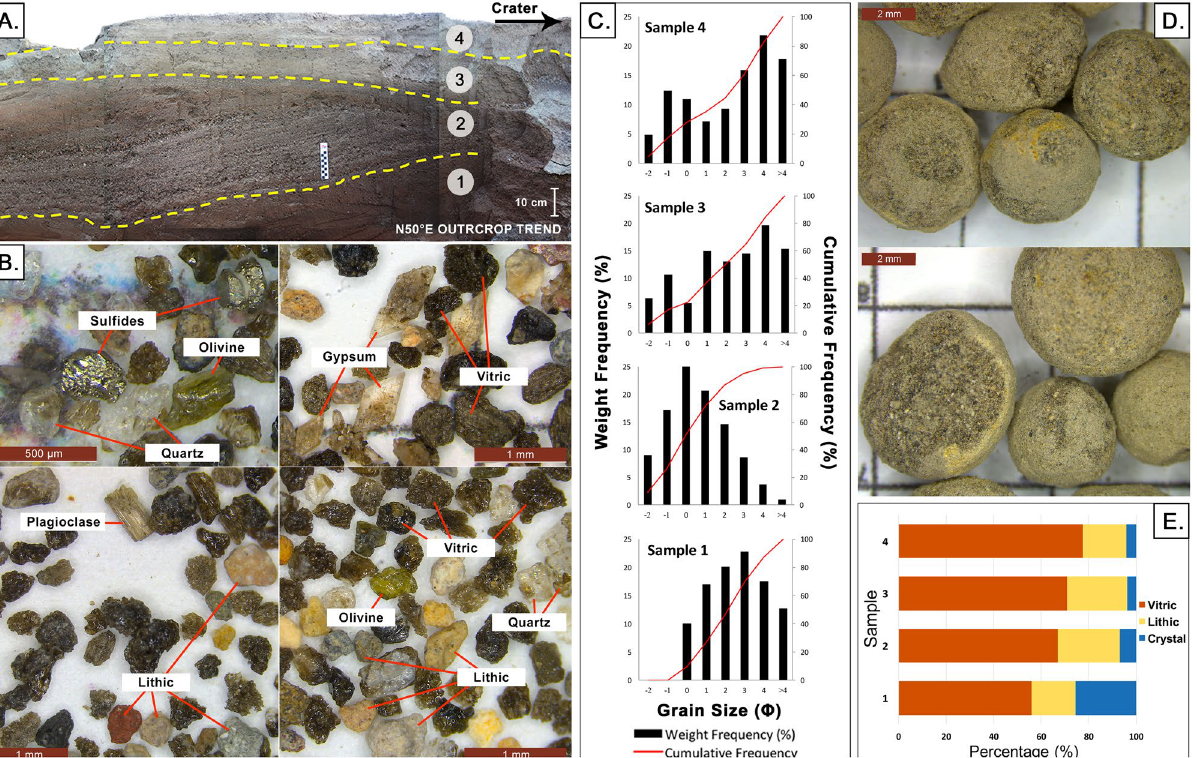
Figure 4. ( A ) Station 1 (14.002304°, 121.008571° Located at Fig. 5D) where samples were collected; ( B ) Ash components including vitric, lithic, and crystals (gypsum, olivine, plagioclase, quartz crystals), as well as secondary quartz and sulfide fragments from the mineralized hydrothermal system; ( C ) Grain size distribution graph per sampled layer; ( D ) Accretionary lapilli found in Samples 3 and 4; ( E ) Relative abundance of the components of ash per